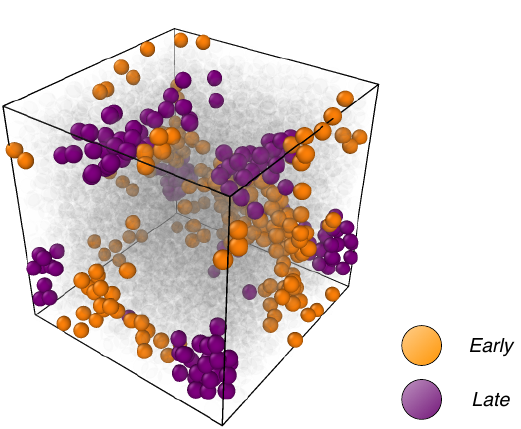
Figure 5. View of one microscopic configuration of the state with ρ = 1.02 and T = 0.42 belonging to the C set. The particles that belong at the early and late fractions are highlighted. Note the tendency of the particles belonging to the two fractions to group into clusters coexisting with isolated particles .